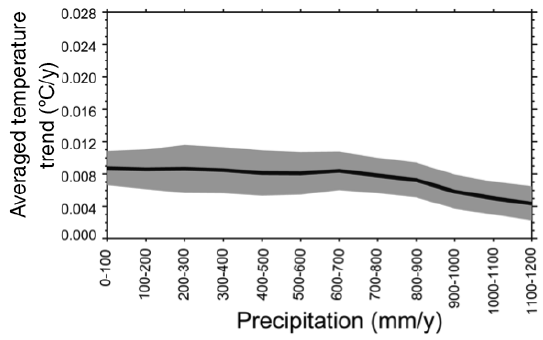
Figure 14. Regional averaged cold season mean-temperature trend as a function of climatological annual mean precipitation over east Asia for ensemble-mean CMIP5 simulations in cold season from 1902 to 2011, shading denotes 95% confidence intervals.